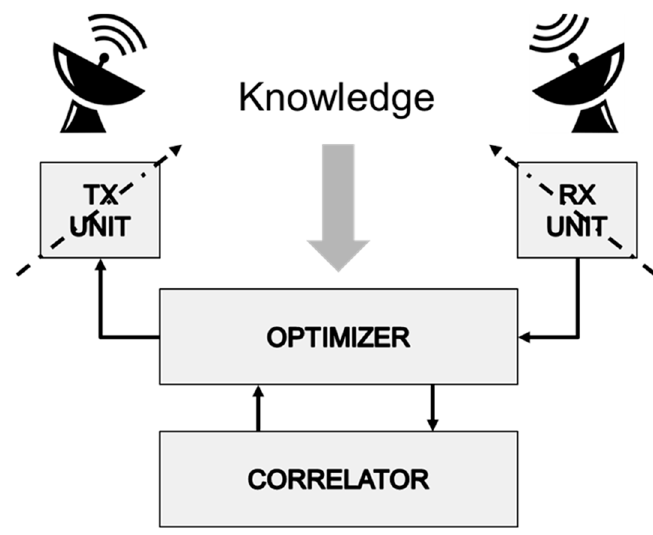
Figure 1. Basic components of a cognitive radar.